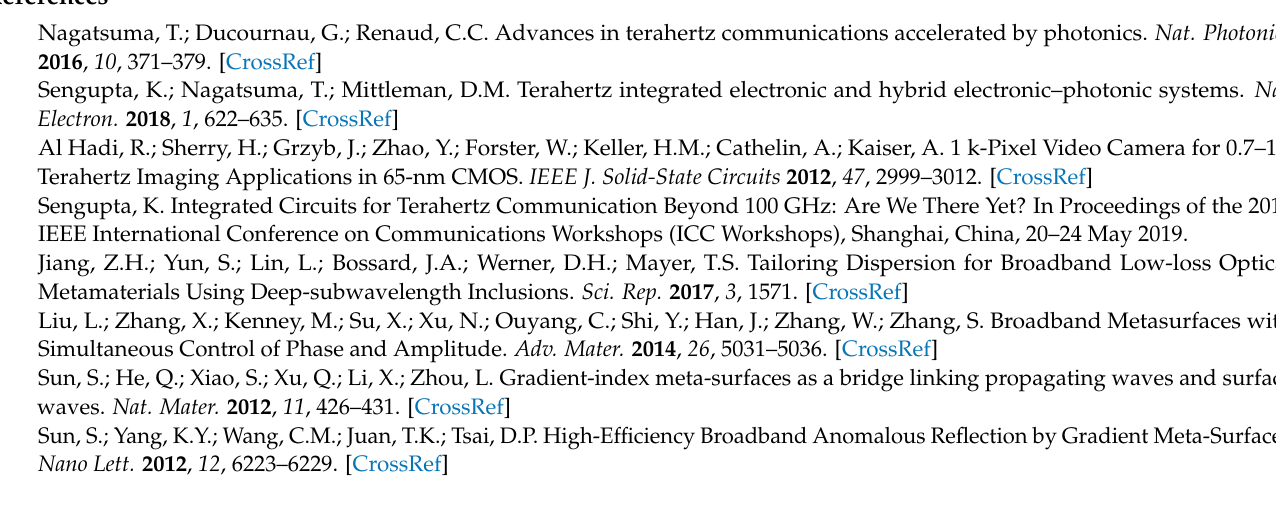
Figure 7. ( a ) Schematic of circular-shape SRR circular polarizer with ( r , α , w , γ ) = (39 µ m, 60 ◦ , 1 µ m, 0 ◦ ) and d 1 = 42.3 µ m. ( b ) Variation of electric field of scattered light in time domain at z = − 10 µ m, where the red and blue line represent the single − layer and two-layered circular-shape SRR polarizers, respectively.